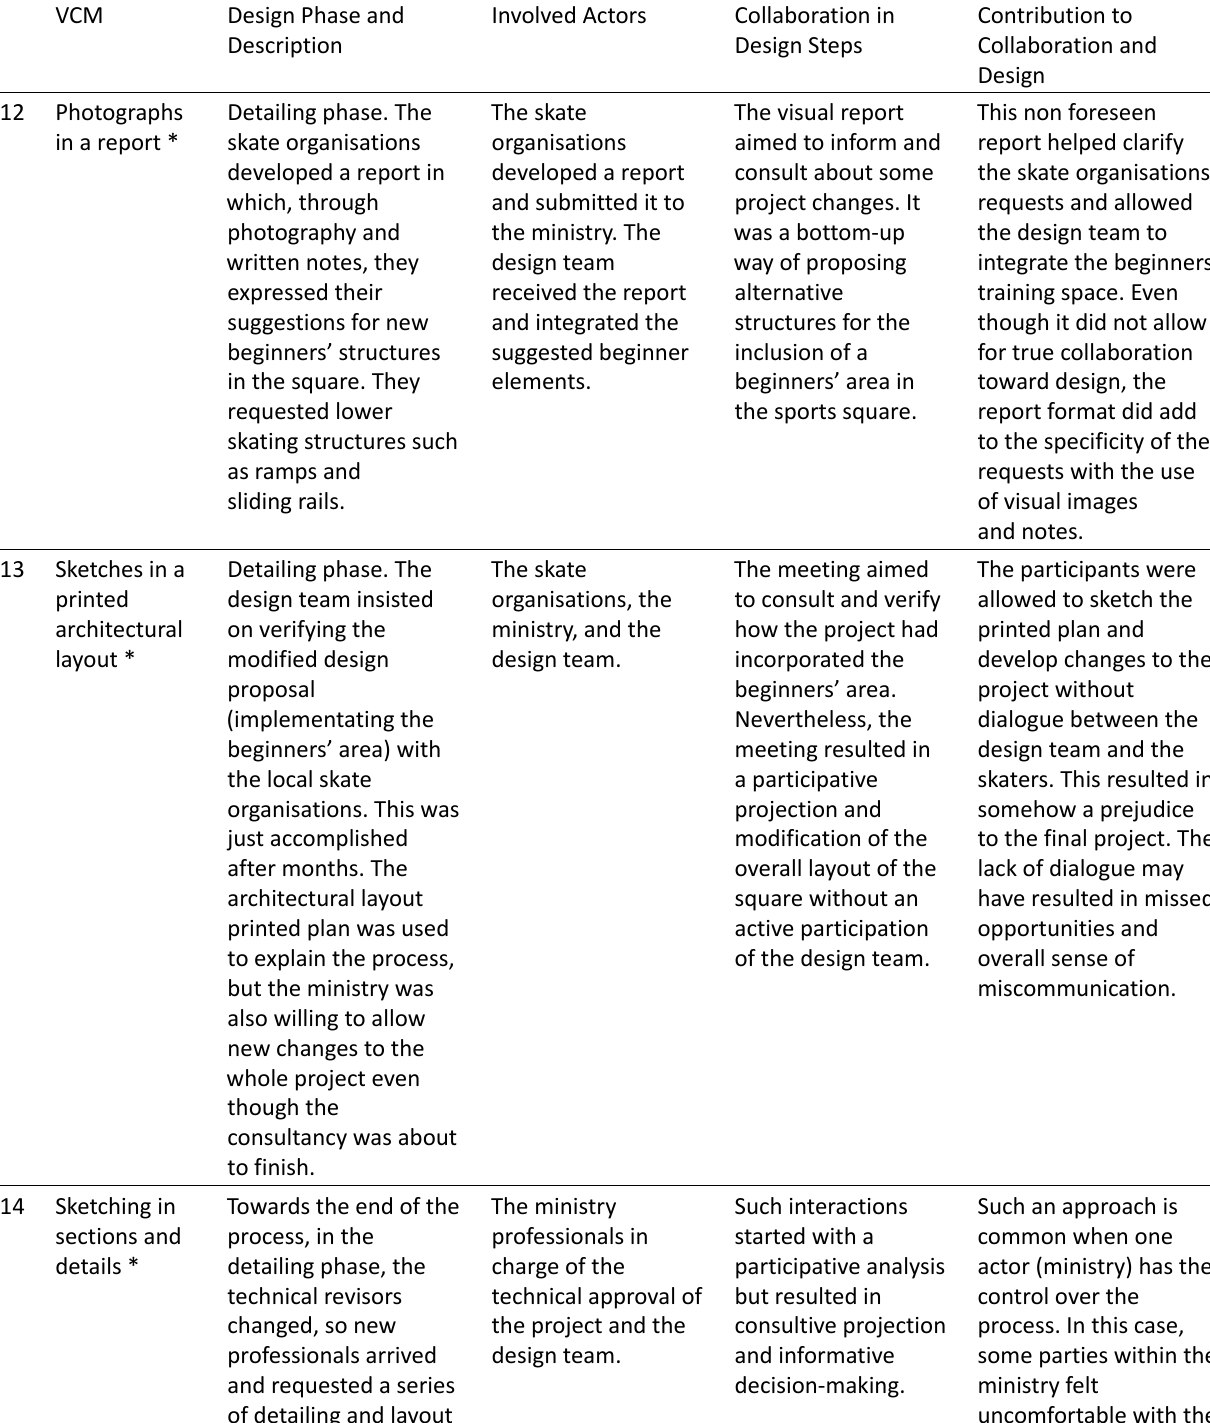
Table 2. (Cont.) VCMs used in the design